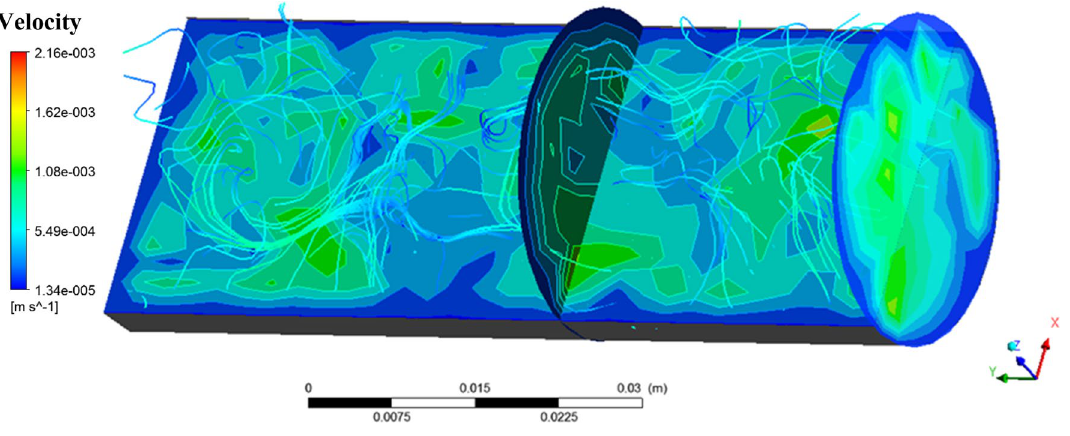
Fig. 8 Flow velocity profile across core sample after wax